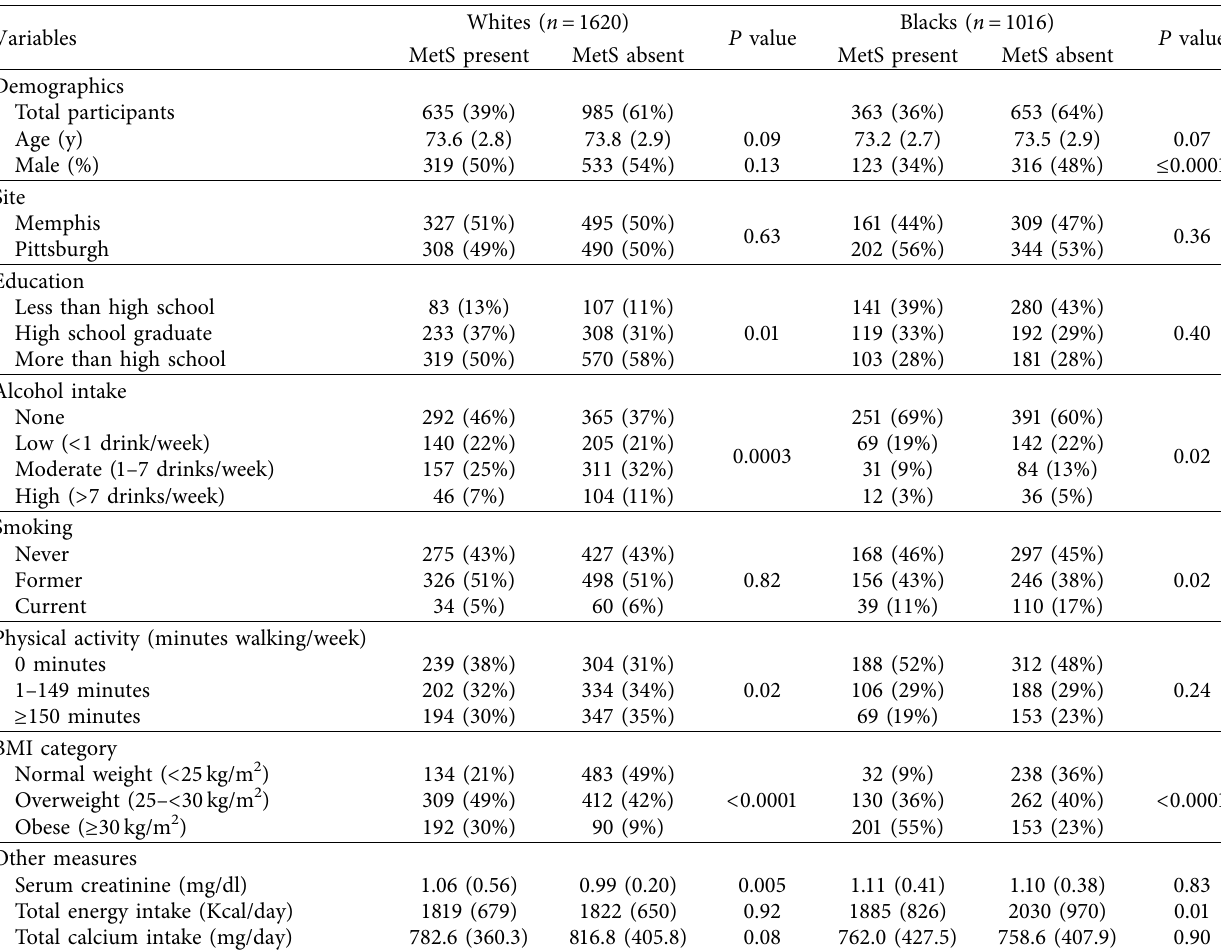
Figure 1: The distribution of 25-hydroxyvitamin D levels in white and black participants classified by the presence or absence of prevalent metabolic syndrome at baseline in the Health ABC cohort ( n � 2636). 25(OH)D, 25-hydroxyvitamin D; MetS, metabolic syndrome. Table 1: Baseline characteristics of the Health ABC participants with and without the presence of metabolic syndrome at baseline by race